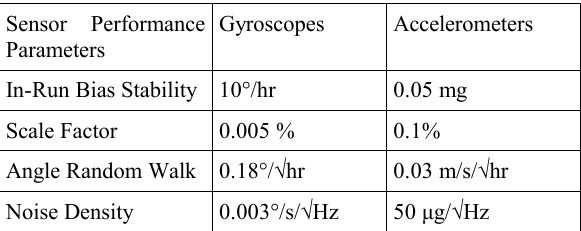
Table 2. Stochastic Characteristic of Inertial Sensors (16 in total, before calibration via